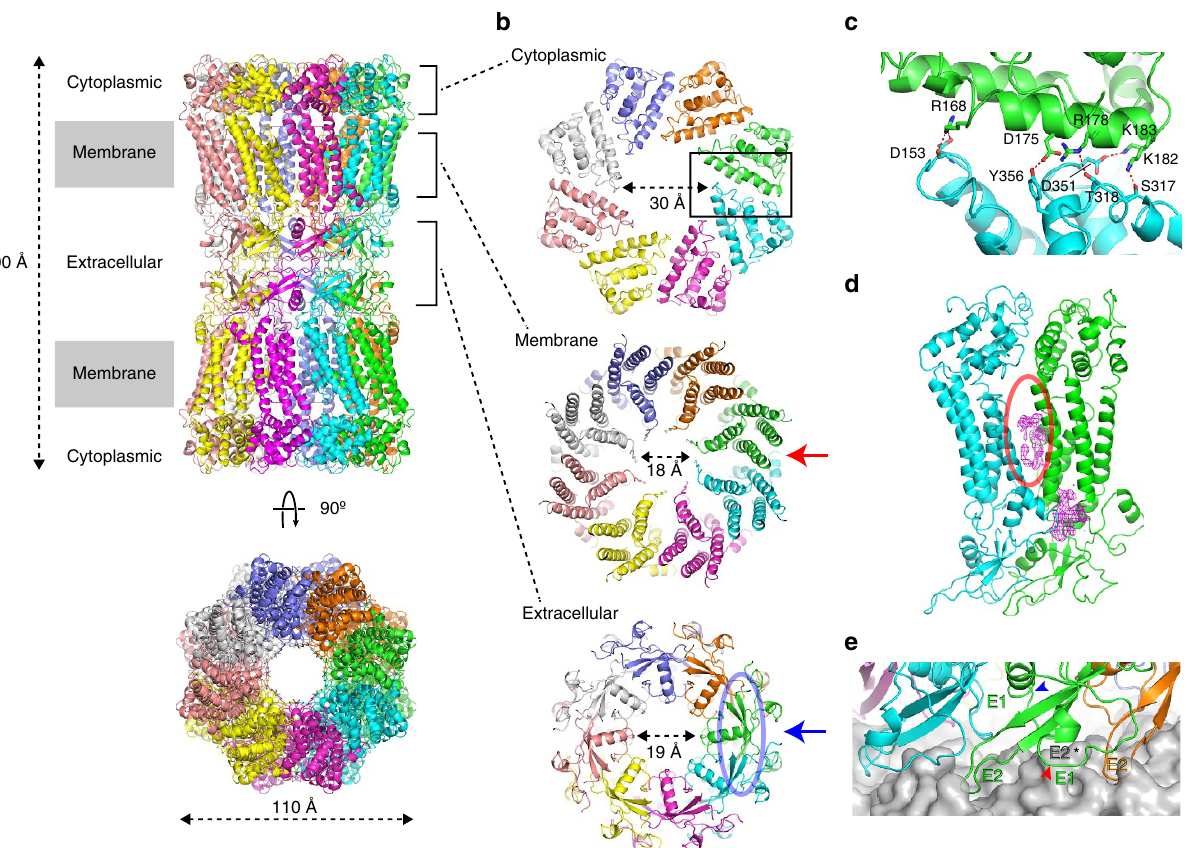
Figure 4 | INX-6 gap junction structure and domain interface interactions. ( a ) Ribbon model of INX-6 gap junction channel in side view (top) and top view (bottom). ( b ) Three segments of INX-6. Cytoplasmic dome (cytoplasmic), transmembrane region (membrane) and extracellular gap region (extracellular) correspond to the brackets in a . ( c ) Magnified view of the inter-subunit interactions in the cytoplasmic dome indicated by the rectangular box in b -cytoplasmic. ( d ) A red circle indicates spacing between the adjacent helix bundles. Unassigned densities (magenta) are located between the two subunits. View orientation is indicated by red arrow in b -membrane. ( e ) Extracellular junction interface corresponding to the blue circle in b -extracellular where view orientation is indicated by blue arrow. The opposed E2 b -hairpin (asterisk) is fit to a cavity formed by the inner (blue arrowhead) and outer (red arrowhead) lobes of E1 and the two adjacent E2 b -hairpins (green and orange). The molecular surface of an opposed hemichannel is coloured in